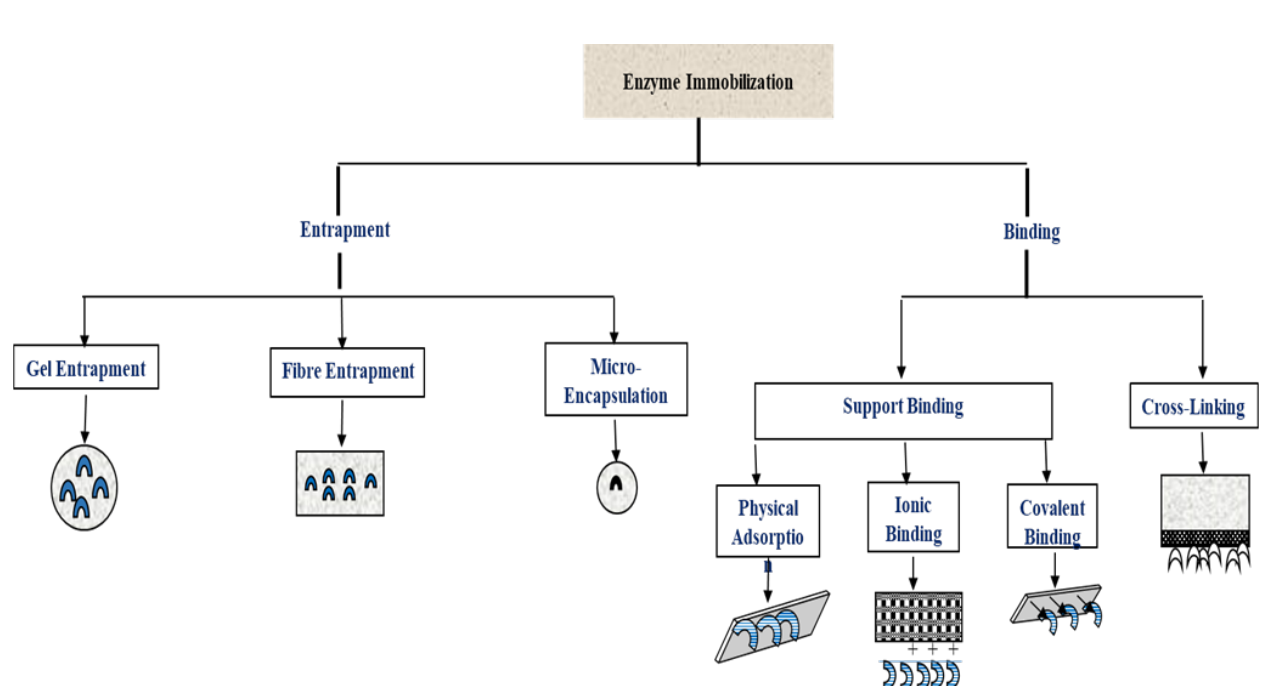
Figure 8. Different biocatalyst immobilization mechanism. Table 3. Advantages and disadvantages of biocatalysts immobilized on porous